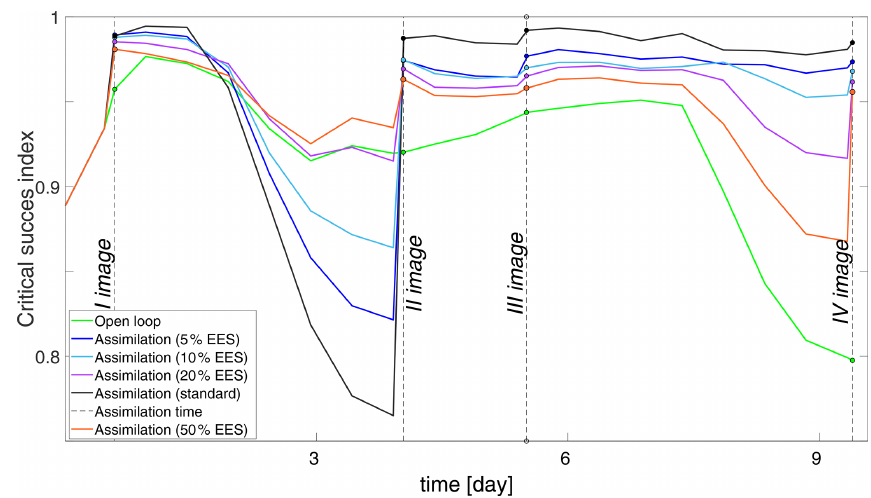
Figure 8. Time series of the CSI of flood extent values for the different assimilation methods: open loop (green), standard assimilation (black), assimilations with 5% EES (blue), 10% EES (cyan), 20% EES (purple), and 50% EES (orange).